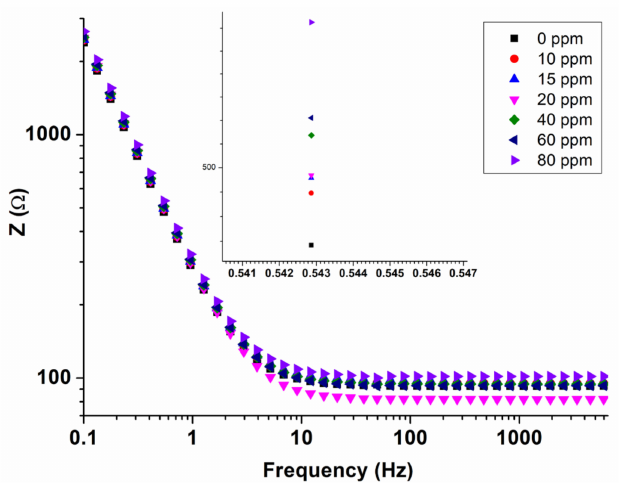
Figure 5. Bode Modulus diagram for modified TiNT GO antibody electrode between 0.1 and 10 5 Hz in phosphate buffer vs. Ag/AgCl 3 MKCl (magnification for 0.543 Hz in the inset). In this diagram, frequency and impedance (Z) are on a logarithmic scale. In the inset can be seen an increased magnification corresponding to the frequency of 0.543 Hz. Nyquist and Bode phase diagrams are not